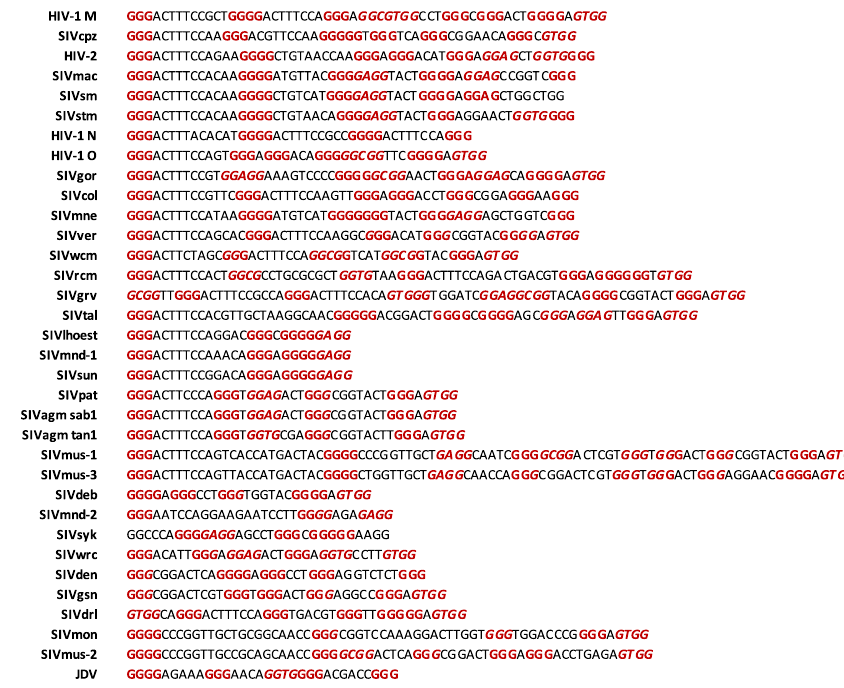
Figure 1. PQS analysis within the LTR region of lentiviruses (our reference HIV-1 group M is at the top of the list). GGG tracts are shown in red and bold; bulged tracts (e.g. GXGG that do not overlap with adjacent GGG tracts) are shown in red, bold and italics. Lower case letters that specify the SIV strain refer to the simian type they were first identified from (e.g. SIVcpz from chimpanzee or Pan troglodytes troglodytes , SIVsm from sooty mangabey monkey or Cercocebus atys ). A complete list of PQS in all lentiviruses along with references and host species is provided in Supporting Table